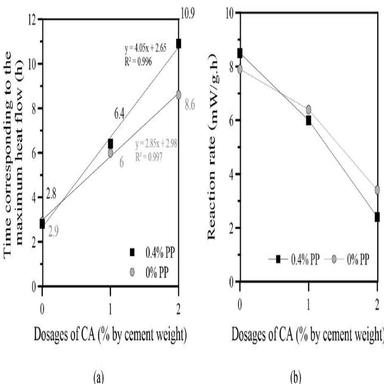
(a) Quantification of the time corresponding to the maximum heat flow and (b) reaction rate of samples with and without PP as a function of CA dosages.